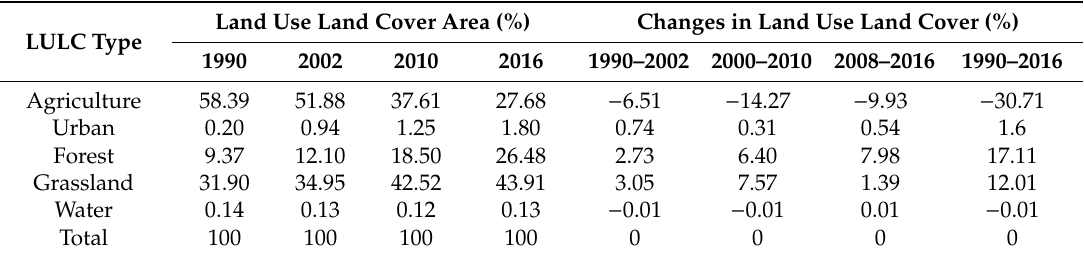
Table 2. The area percentage of land use land cover from 1990–2016 period in the Yanhe catchment. Land Use Land Cover Area (%) LULC Type